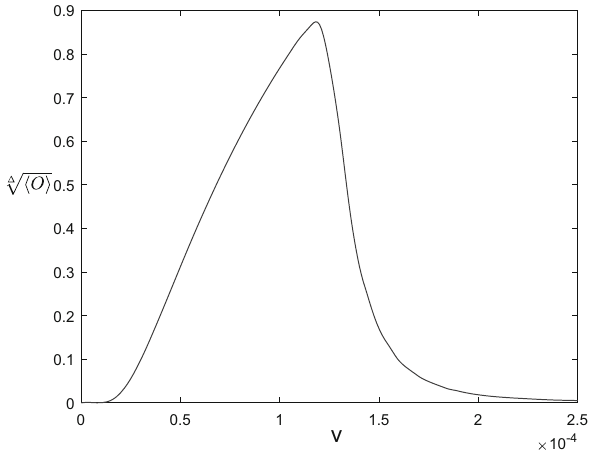
Fig. 7 The remaining p-wave condensate (cid:9) quenching process at different values of quench rate v in quenching processes across the reentrant region